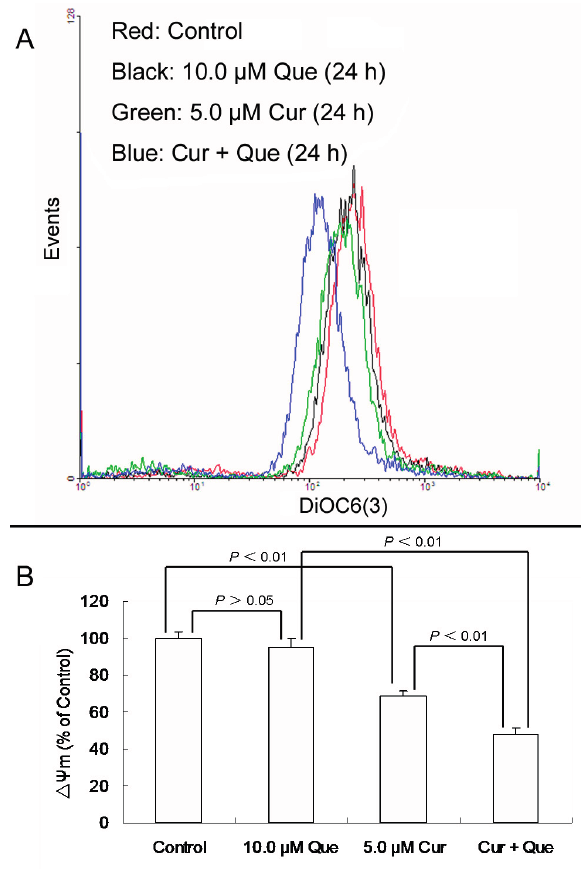
Figure 3. Effect of quercetin and curcumin on ΔΨ m in MGC-803 cells. After treatment with quercetin (10.0 µM) and/or curcumin (5.0 µM) for 24 h, cells were incubated with DiOC6(3) and then measured by flow cytometry. ( A ) Collapse of ΔΨ m was observed in MGC-803 cells. ( B ) ΔΨ m levels are expressed as percentage of MFI compared to control group. Data are expressed as mean ± SD of at least three determinations. p < 0.05 and p < 0.01 represent a significant difference among